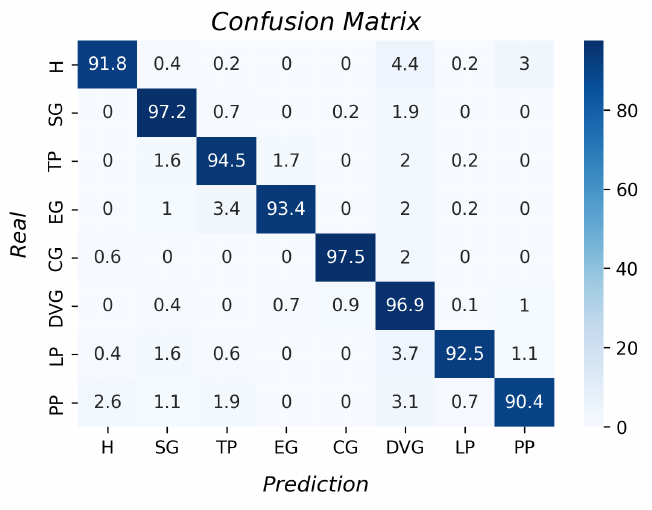
Figure 14. Accuracy per grasp type for the support vector machine algorithm.